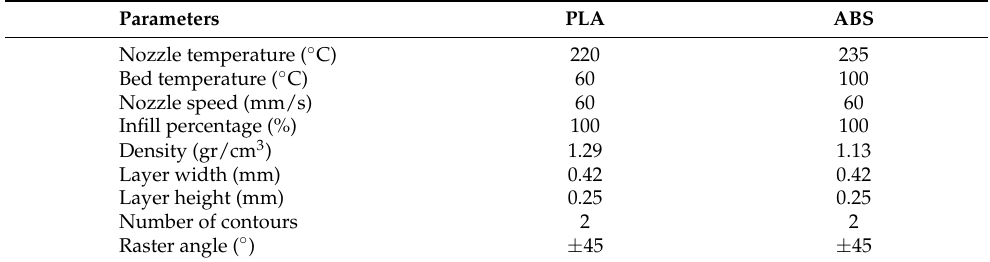
Table 1. Processing parameters and properties of 3D-printed PLA and ABS specimens.